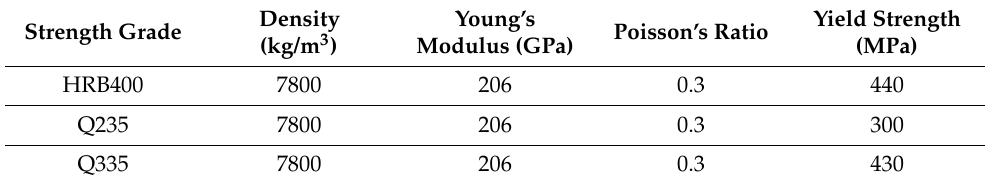
Table 3. Material properties of steel plate and